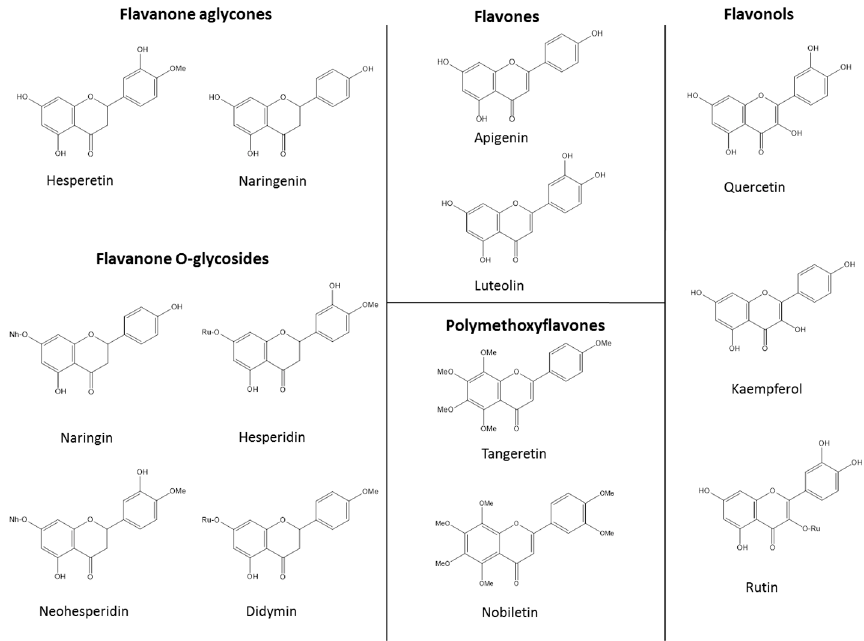
Figure 2. Molecular structure of Citrus flavonoids discussed in this review. Rutinose (Ru), neohesperidose (Nh), methoxy (Me).